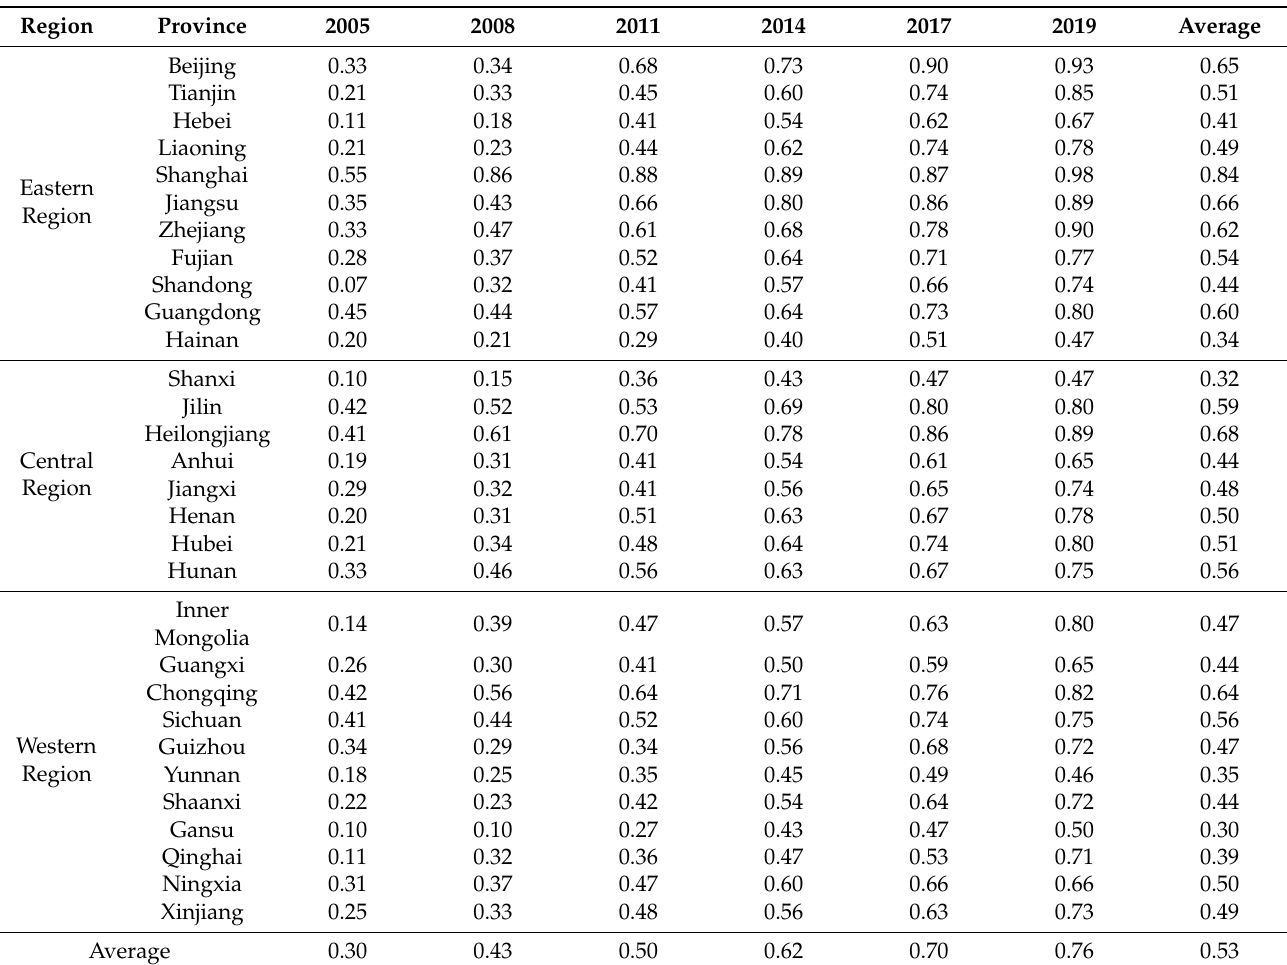
Table 3. The coordination degree in regard to farmland transfer and CLGUE in main